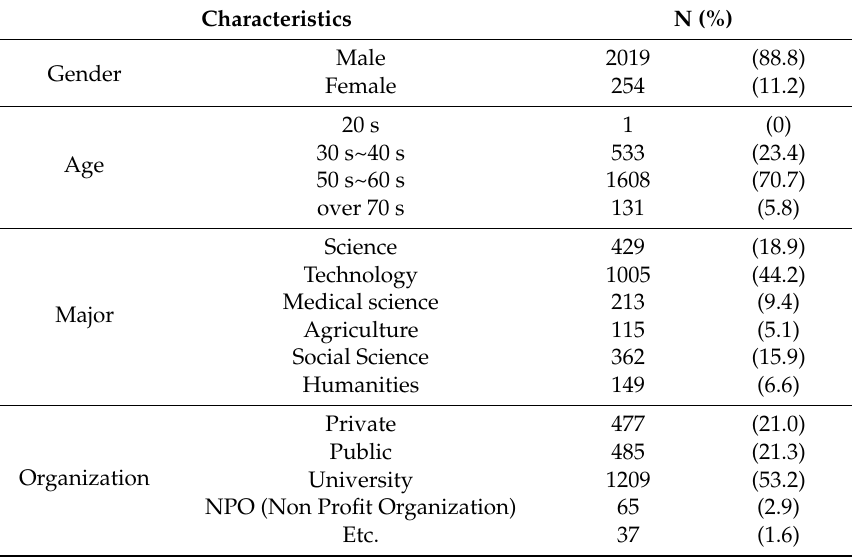
Table 1. The characteristics of the